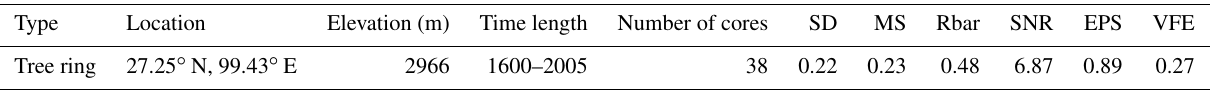
Figure 3. Plot of tree-ring residual chronology, the running intercorrelations among cores (Rbar, the green line), expressed population signal (EPS, the blue line) and the sample size (the red line). The Rbar and EPS were calculated using a 30-year window, with a 15-year lag. The horizontal dashed line denotes the EPS threshold level (0.85). Table 1. Site information, chronology statistics and results of a common interval span analysis of residual tree-ring width (TRW) chronology from the Xinzhu village, northwestern Yunnan, in